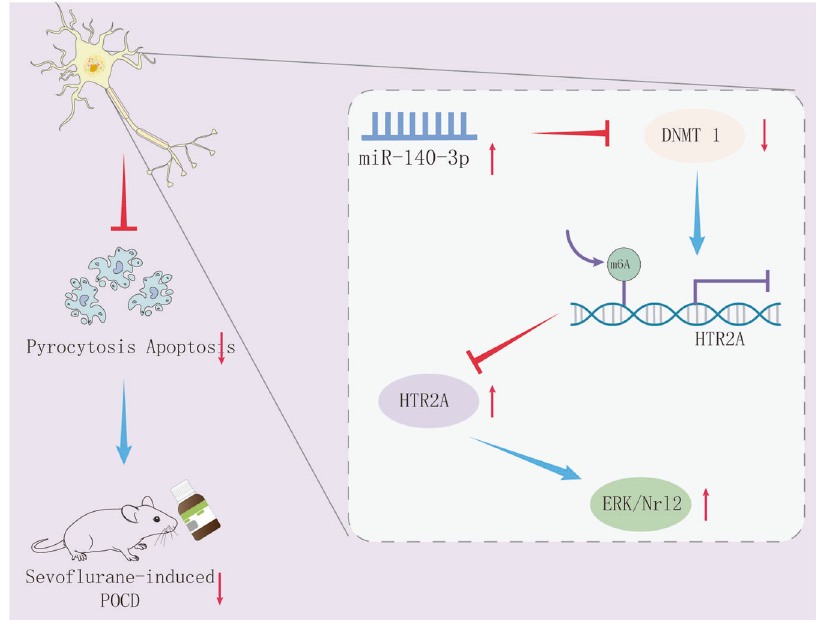
Fig. 8 Mechanism of miR-140-3p diminishing hippocampal neuron pyroptosis to alleviate Sevo inhalation-induced POCD in rats via DNMT1/ HTR2A/ERK/Nrf2